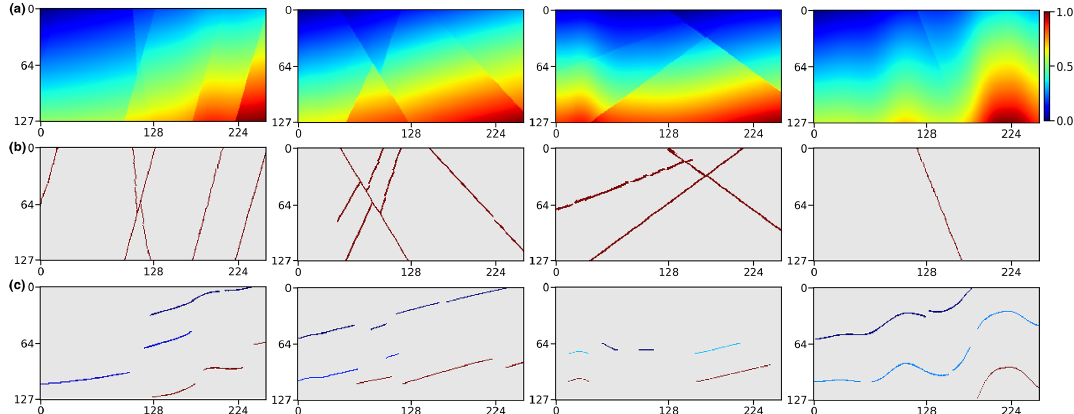
Figure 5. A total of four pairs of 2-D training data samples are shown. The first row displays 2-D synthetic implicit structural models used as labels in training our 2-D CNN. The second and third rows, respectively, show the fault images and sparse horizon points extracted from the label models (first row), which are used together as inputs to the CNN. It is worth noting that the points denoted by the same color in each image in the third row correspond to the same